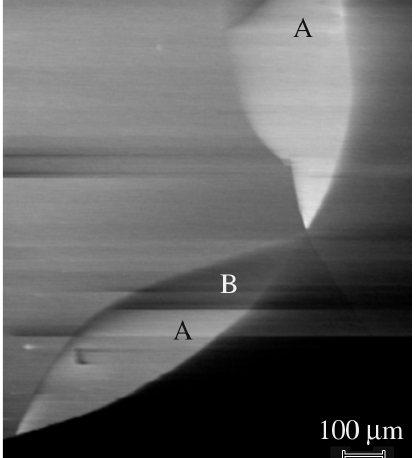
Figure 17. EBIC image of fragment of the Schottky diode formed on the sample S6.